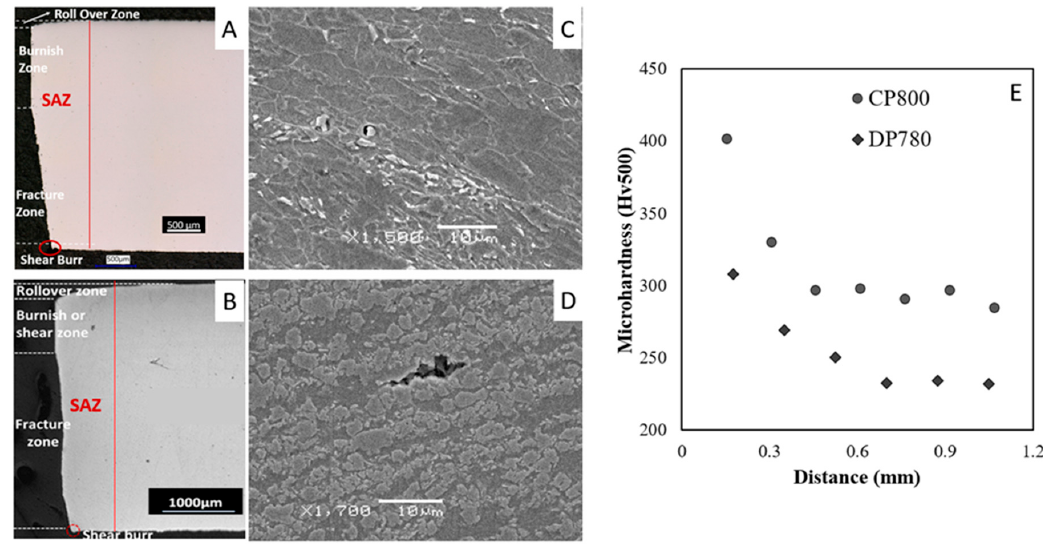
Figure 3. Sheared edge of CP800 ( A ); and DP780 ( B ); consisting four zones: rollover, burnish, fracture, and burr. Pre-nucleated voids are found in the shear-affected-zone away from the CP800 ( C ); and DP780 ( D ) sheared edge; ( E ) the hardness profile for the two sheared edges in the rolling direction.